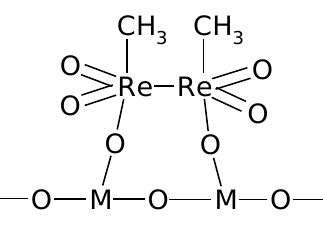
Figure 4. Structure of MTO dimer based on data obtained from UV-Vis spectra (M = Si, Al).